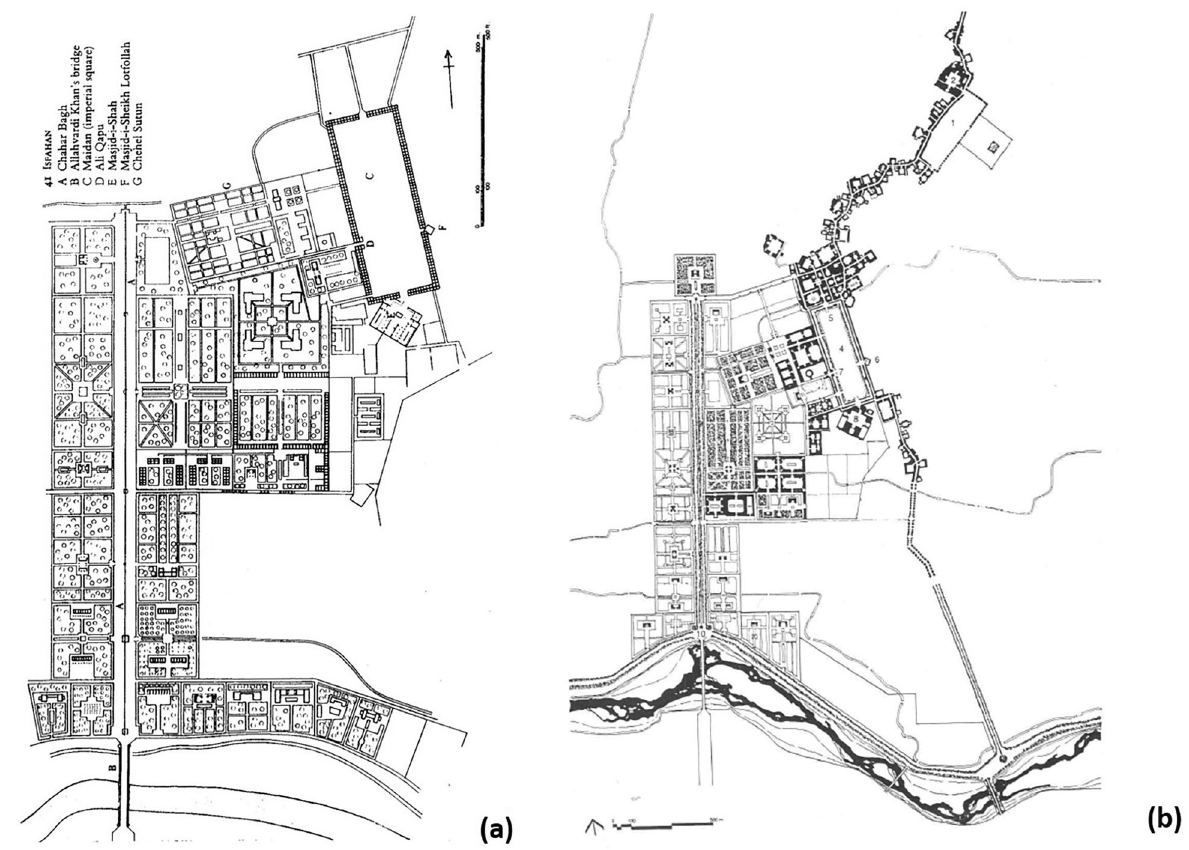
Fig. 4 Isfahan city plans. Plans used for the fractal analysis. Sources: ( a ) Jellicoe and Jellicoe, 1987, p. 50. https://www. fl ickr.com/photos/quadralectics/ 4269101648 [Accessed 1 June 2019]; ( b ) Drawing by Nadar Ardalan, in Trancik, 1986. https://classconnection.s3.amazonaws.com/279/ fl ashcards/ 2821279/png/arch_541361404714733.png [Accessed 1 June 2019].